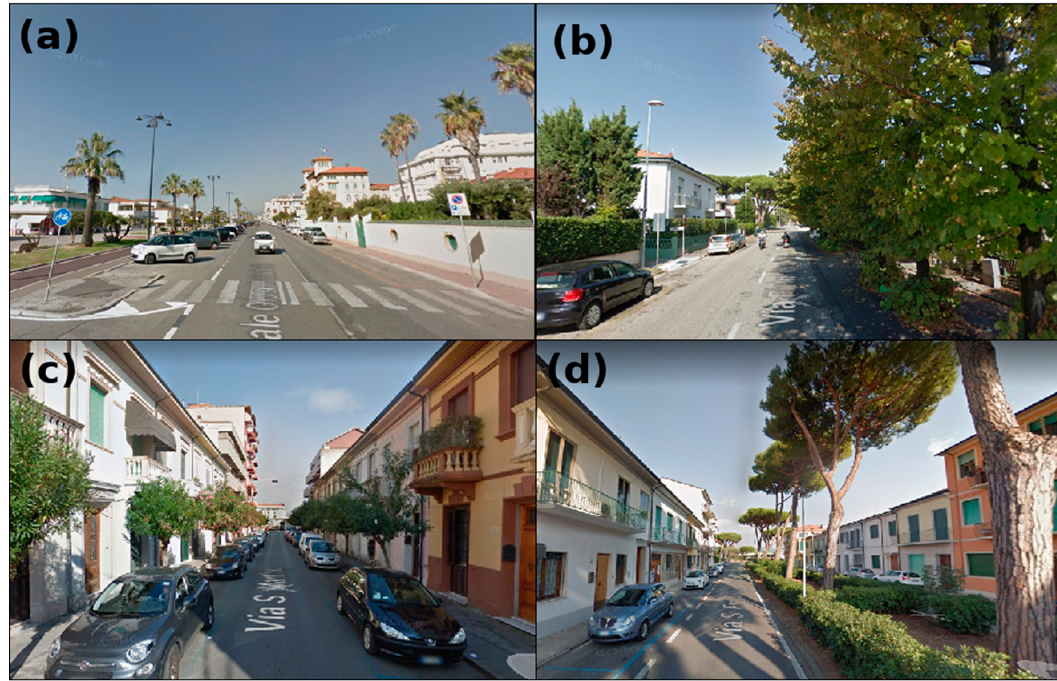
Figure 13. Typical representative public greenery: ( a ) promenade, ( b ) pine forest within the urban area, ( c ) are rows of small plants along the sidewalks, ( d ) trees in the middle of roads.